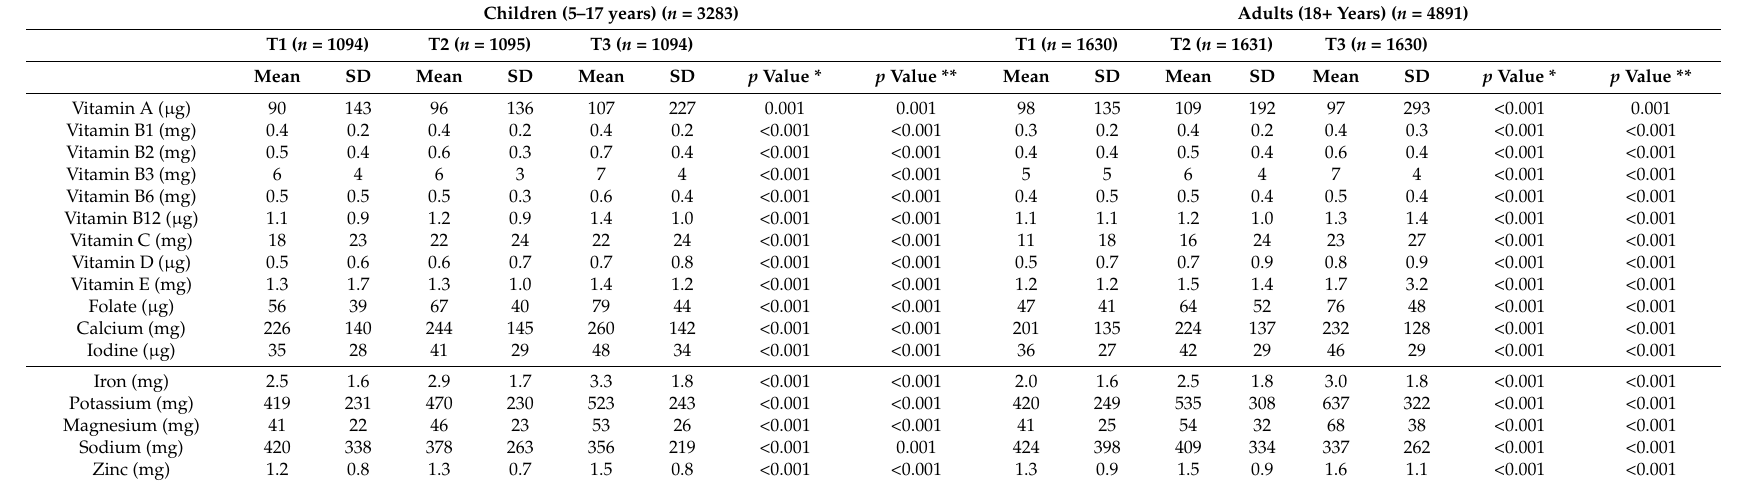
Table 4. Mean (SD) intake of micronutrients at breakfast across tertiles of NRF 9.3 score by age